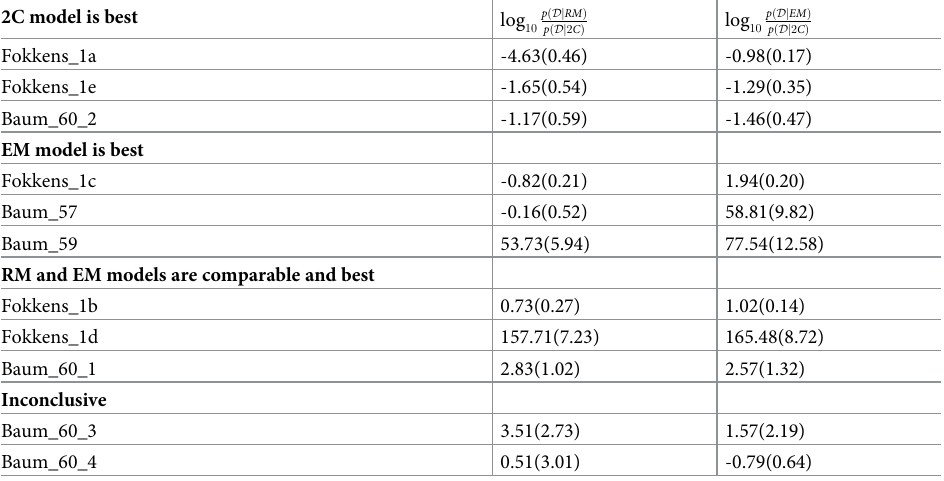
Table 3. Estimated log 10 of Bayes factors. Numbers in parentheses are standard errors estimated by the standard devi- ations of 1000 bootstrap samples. 2C model is